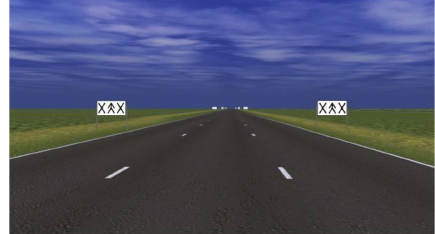
Figure 5: Lane Change Test screenshot [29].